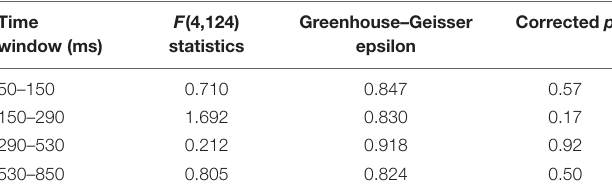
TABLE 4 | Statistics for interaction effects of arousal and subjective significance on mean amplitudes in the analyzed time windows. Time window (ms)